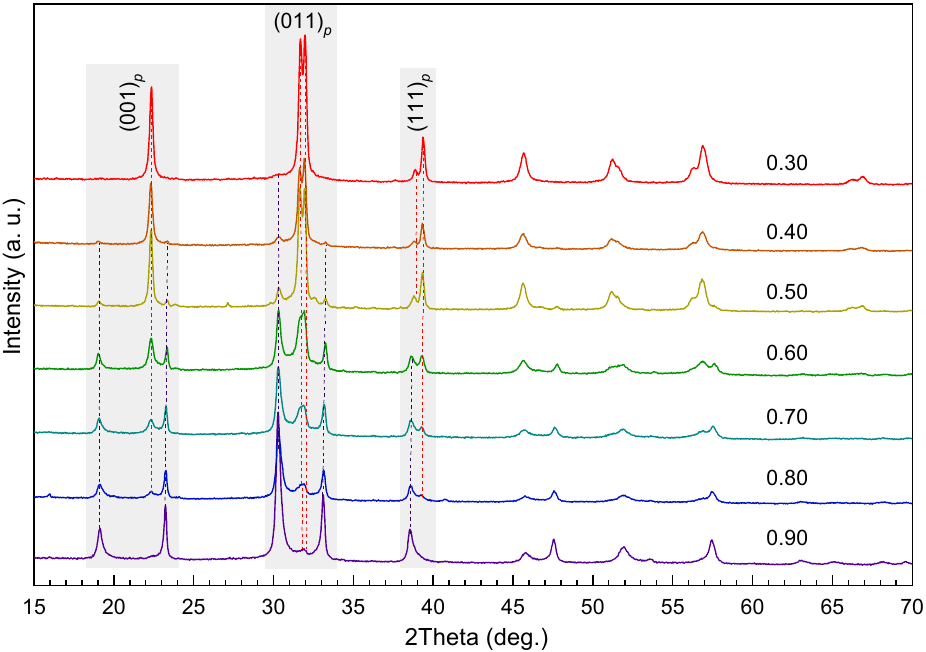
Figure 1. The XRD patterns of the (1 − y )BiFeO 3 – y BiZn 0.5 Ti 0.5 O 3 samples as-synthesized under high pressure. The numbers at the diffractograms denote the y values. The shadow areas indicate the angular ranges of (001) p , (011) p and (111) p reflection families of the primitive perovskite lattice. The dotted lines point out the 2Theta positions of the reflections corresponding to the rhombohedral R 3 c phase (red lines) and the tetragonal P 4 mm phase (blue